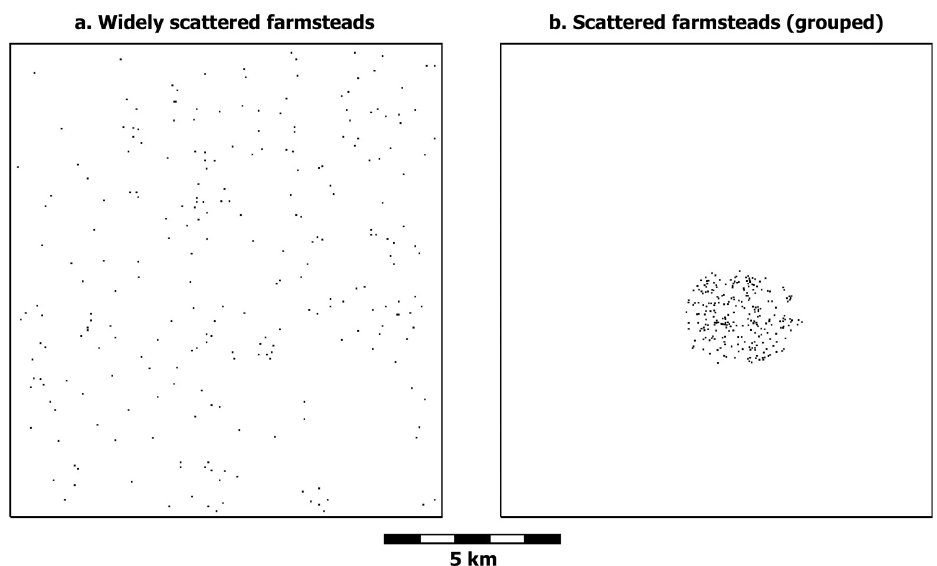
Fig 2. Two hypothetical farmstead distributions. a) widely scattered farmsteads and b) farmsteads grouped more closely together within the same area. Average nearest neighbor distance is 440 m in Fig 2A and 88 m in Fig 2B. Both images have 250 households and thus the same regional population density (7.5 persons/km 2 ). Based on modern household distributions in southwestern Colombia.